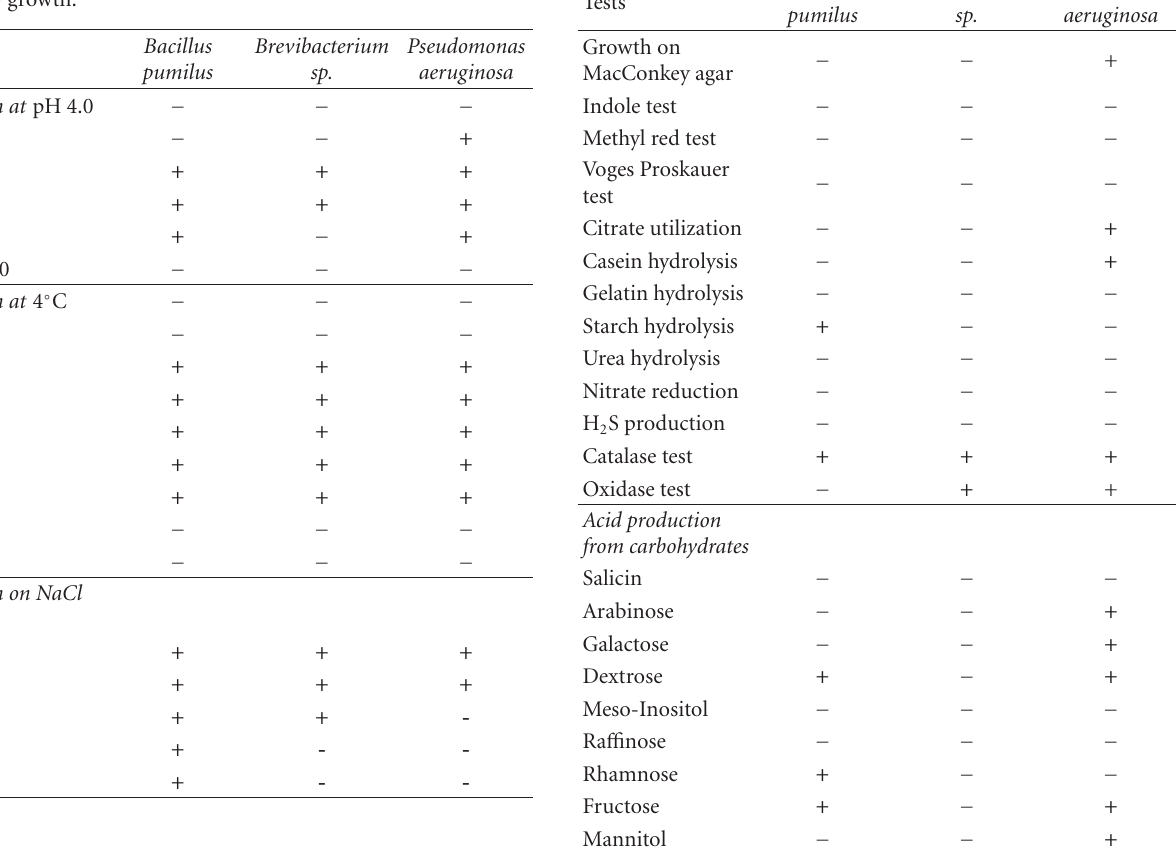
Table 3: Study of physiological features (pH, temperature, and NaCl concentration) of identified strains. ( − ) represents no growth and (+) growth.